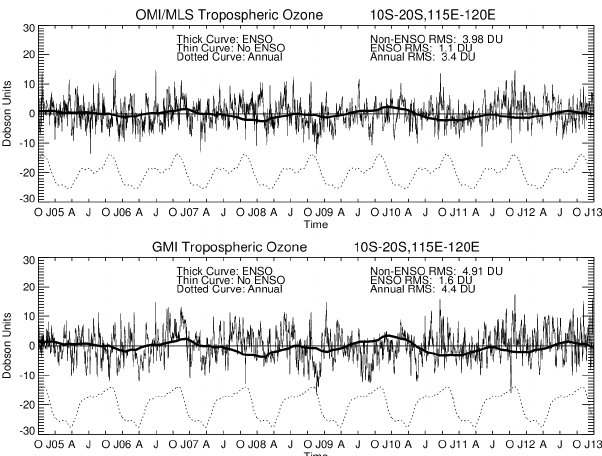
Figure A2. Top: OMI/MLS tropospheric column ozone (in Dob- son Units) for the ENSO regression fit (thick curve) and non-ENSO components (thin curve). Also shown is the estimated annual cycle (dotted curve) which is offset from its average value by − 20DU for plotting. The chosen region for these time series is 10–20 ◦ S, 115– 120 ◦ E and coincides with largest ENSO variability. Included in the panel are RMS values for the ENSO, non-ENSO, and annual cycle time series. ENSO signals were extracted from the deseasonalized time series using the linear regression T (t) = β × Nino34 (t) + ε(t) , where T is deseasonalized time series, t is day index, β is a de- rived constant, Nino34 (t) is the Niño 3.4 ENSO index, and ε(t) is the residual. Bottom: same as top panel except for the GMI CTM instead of OMI/MLS. The average annual cycle value for OMI/MLS TCO (GMI TCO) is 26.0 (31.2)DU; annual cycle min- imum for OMI/MLS and GMI occurs in March–April with max- imum in October–November. Correlation between the GMI and OMI/MLS non-ENSO time series is